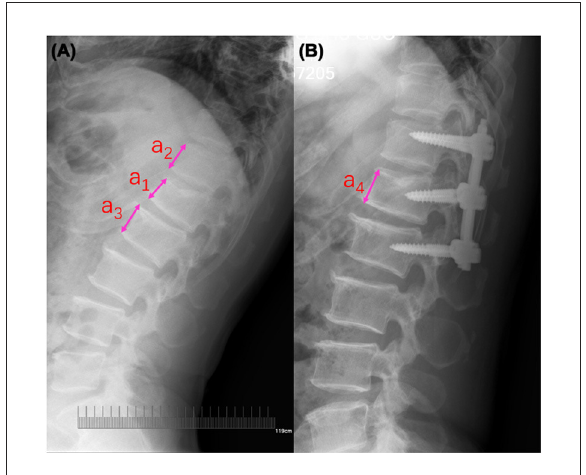
FIGURE1 Radiographic measurement of the fractured vertebral body. (A) Pre-operative lateral radiograph; a 1 is defined as the height of the fractured vertebra; the heights of the upper and lower anterior vertebrae that were adjacent to the fractured vertebra were presented as a 2 and a 3 , respectively. (B) Post-operative lateral radiograph; a 4 is defined as the height of the post-operative vertebra; the average height of a 2 and a 3 is calculated and defined as the predicted height of fractured vertebra (a 5